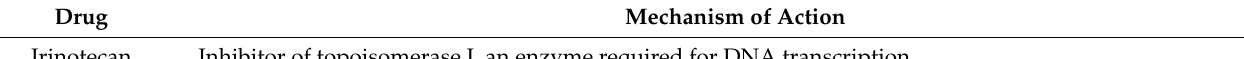
Table 1. The mechanisms of action of each drug against high-grade gliomas. Drug Mechanism of